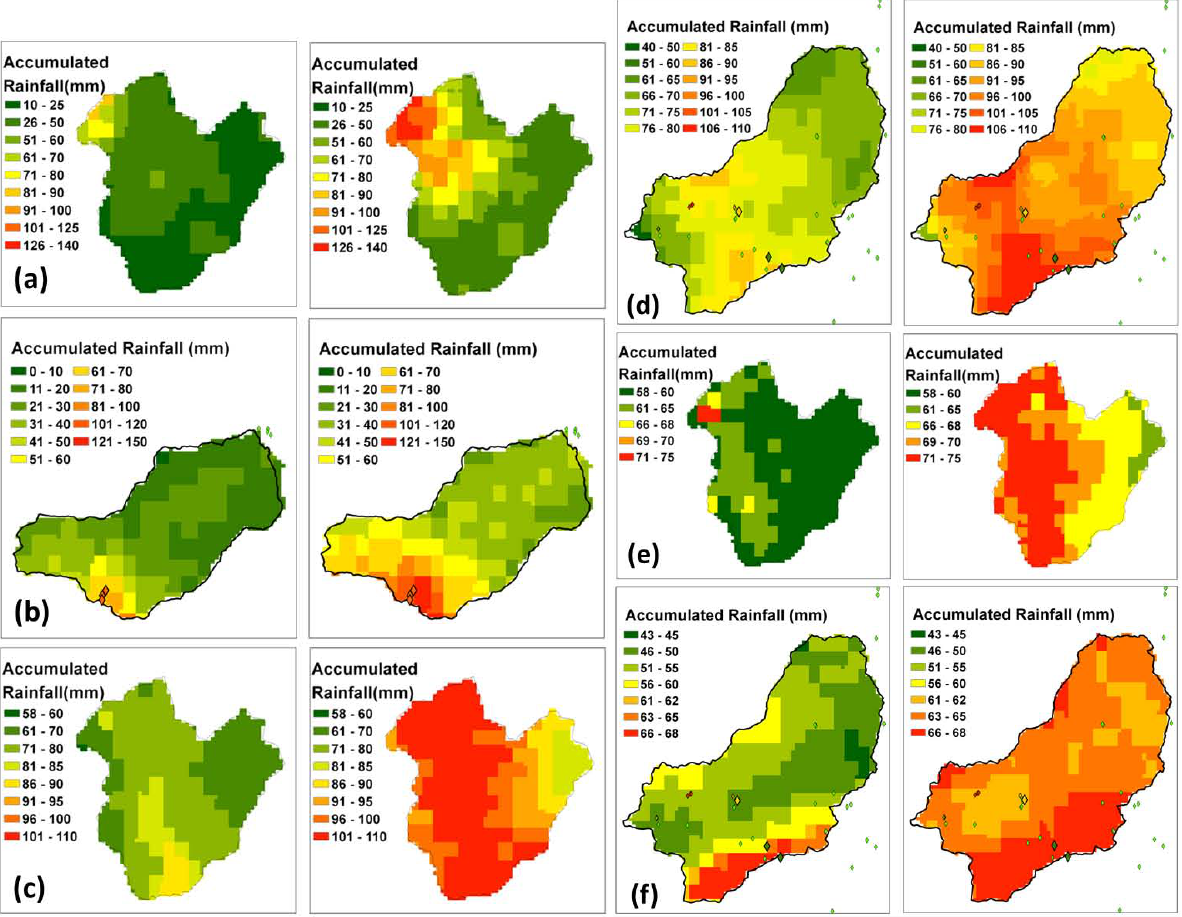
Fig. 5. Comparison between the accumulated Q2 rainfall before (left) and after (right) adjustment during 12 to 17 July 2011 for CCB (a) and BCB (b) , during 5 to 10 January 2009 for CCB (c) and JCB (d) , and 6 to 11 December 2009 for CCB (e) and JCB (f) . Table 3. Summary of the RMSE (mmh − 1 ) computed from observed rainfall rate (mmh − 1 ) and Q2 product before and after adjustment, at rain gauge locations surrounding each basin.